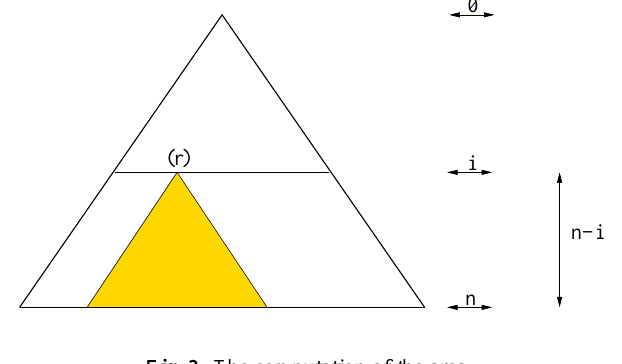
Fig. 3: The computation of the